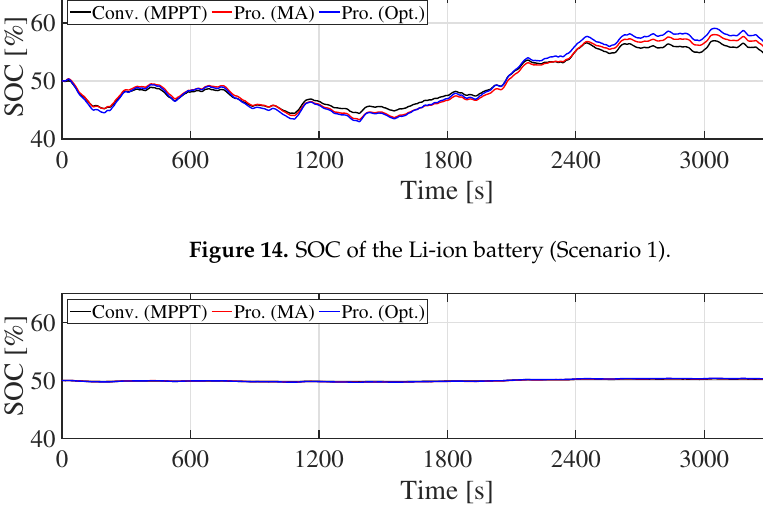
Figure 15. SOC of the NaS battery (Scenario